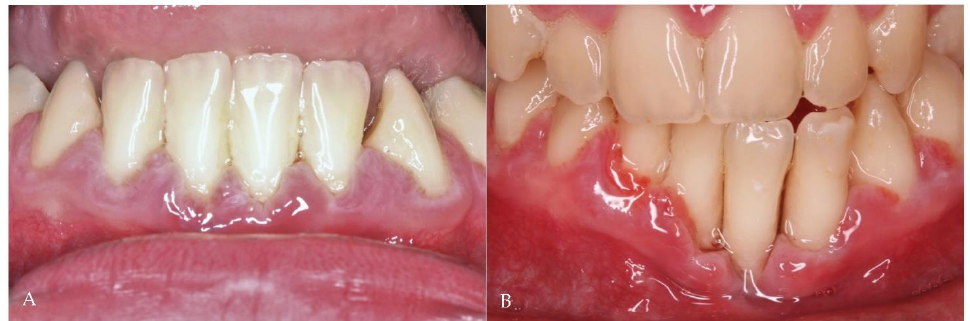
Figure 2. ( A ) Periodontal disease involving anterior teeth; ( B ) Periodontal disease progression despite periodic mechanical treatment (3 years later).